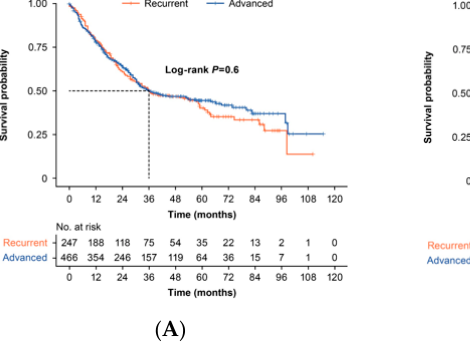
Figure 2. Kaplan–Meier curves of OS (unadjusted) after first-line or second-line treatment in EC patients treated with or without PBCT. ( A ) OS from first-line therapy in patients with recurrent (orange) or advanced (blue) EC. The corresponding table shows the number at risk at each time point (log-rank p = 0.6). ( B ) OS from second-line therapy among patients treated with first-line platinum-based chemotherapy with recurrent (orange) or advanced (blue) EC; p = 0.5 ( C ) OS from second-line therapy among patients who received a platinum regimen in the first line and were then rechallenged with platinum-based chemotherapy (blue) vs. those with no rechallenge (orange). Dotted lines indicate median survival at a 50% survival probability; p < 0.001. OS, overall